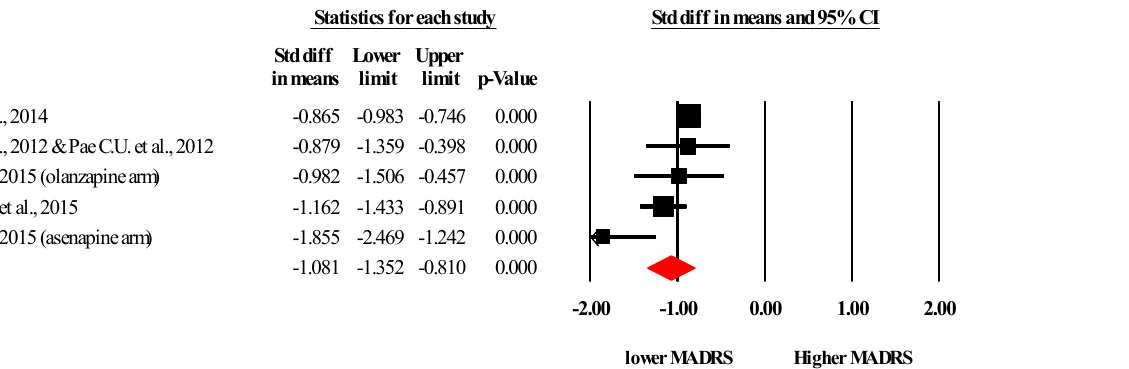
Figure 3. Forest plot of the Montgomery–Åsberg Depression Rating Scale (MADRS) across